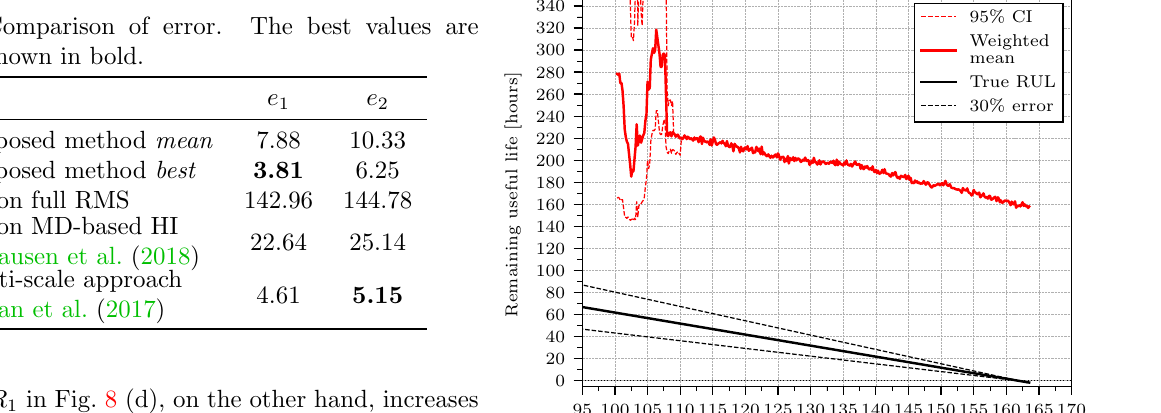
with marked part as 1 converges. α